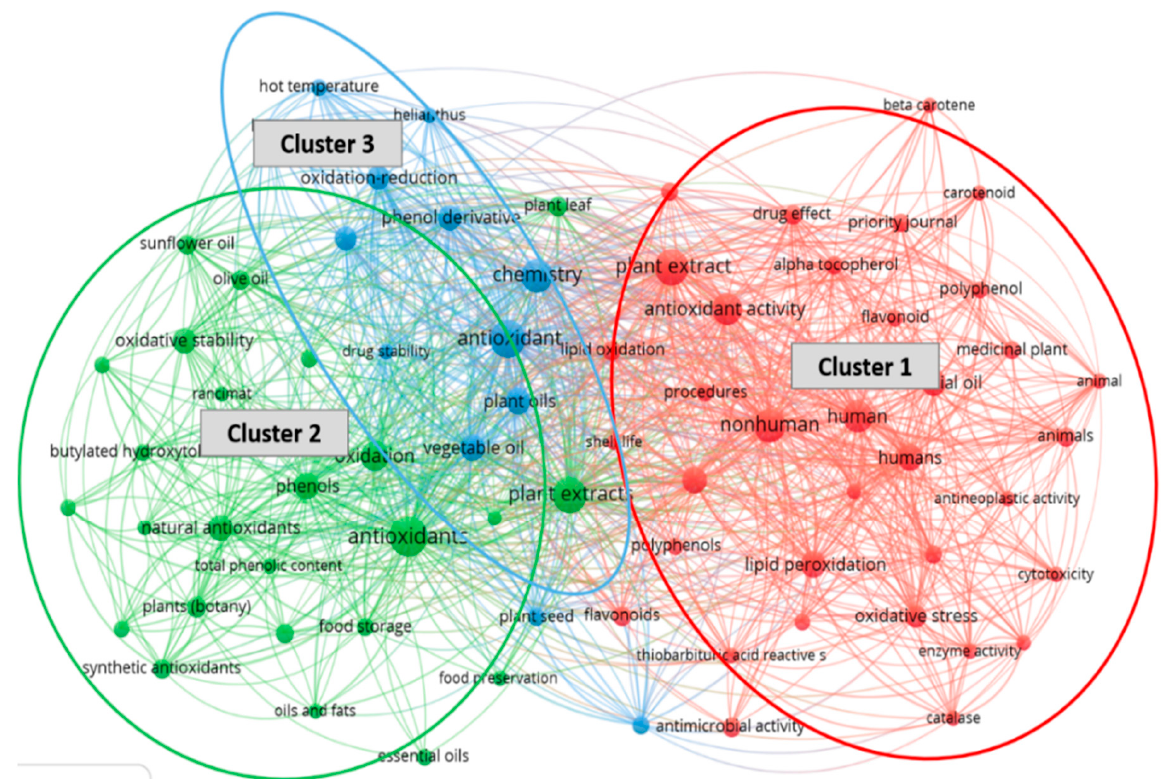
Figure 8. Terms map based on Scopus database carried out using VOS viewer software.